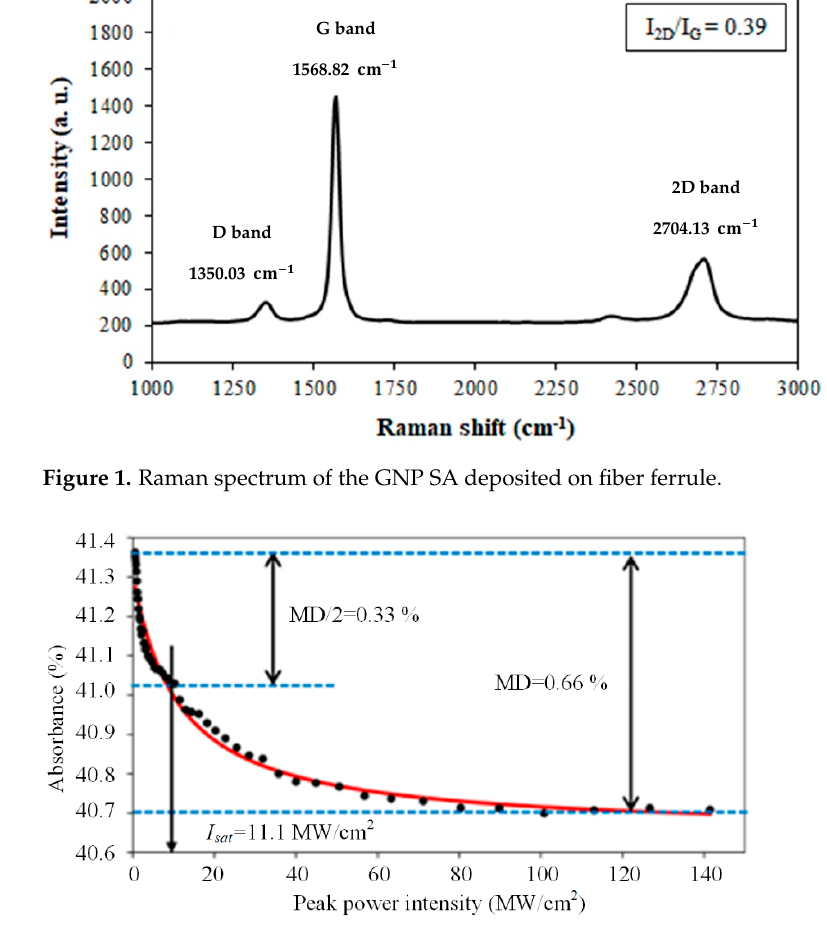
Figure 2. Nonlinear saturable absorbance properties of GNP SA.